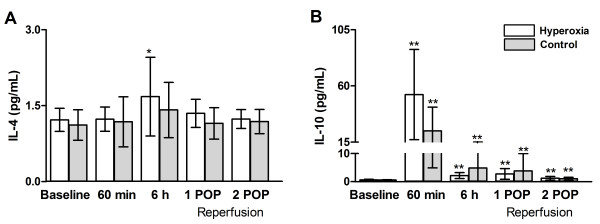
Concentrations of anti-inflammatory cytokines (IL-4 – panel A, IL-10 – panel B) at baseline, 6 h after declamping the aorta and in the 1stand 2ndpostoperative mornings (POP). Data are given as mean (SD). ** p < 0.01 in comparison with baseline, * p < 0.05 in comparison with baseline.